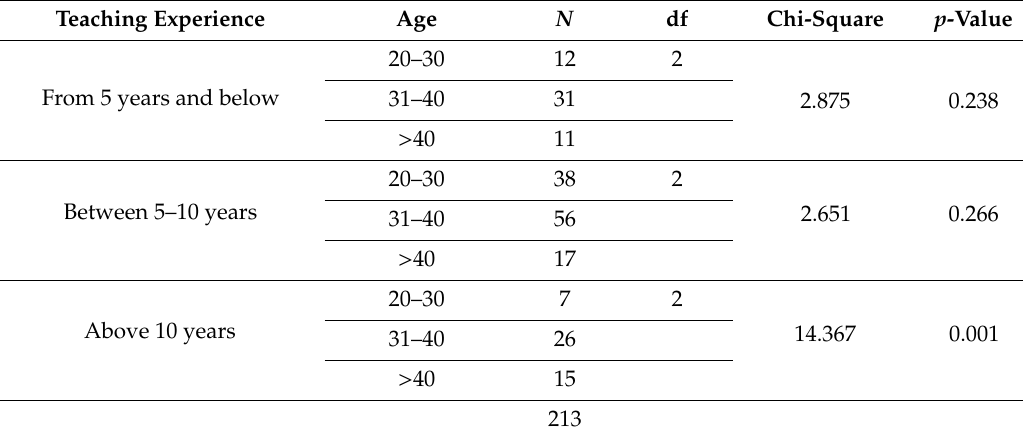
Table 6. Kruskal–Wallis Test for religious belief (age with teaching